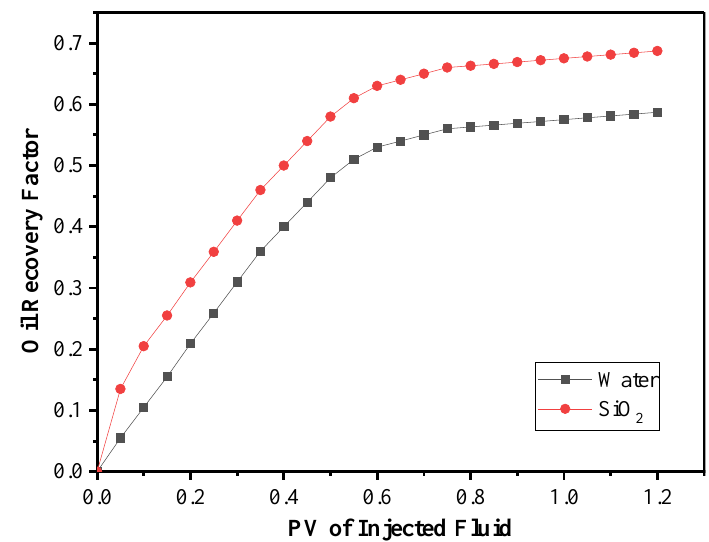
Figure 10. Comparison of the water and the nanofluid recovery factor.